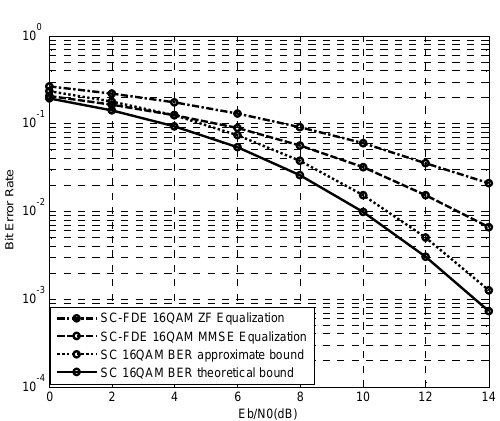
Figure 1 the SC-FDE BER performance of SUI-3 6-path channel model under QPSK modulation